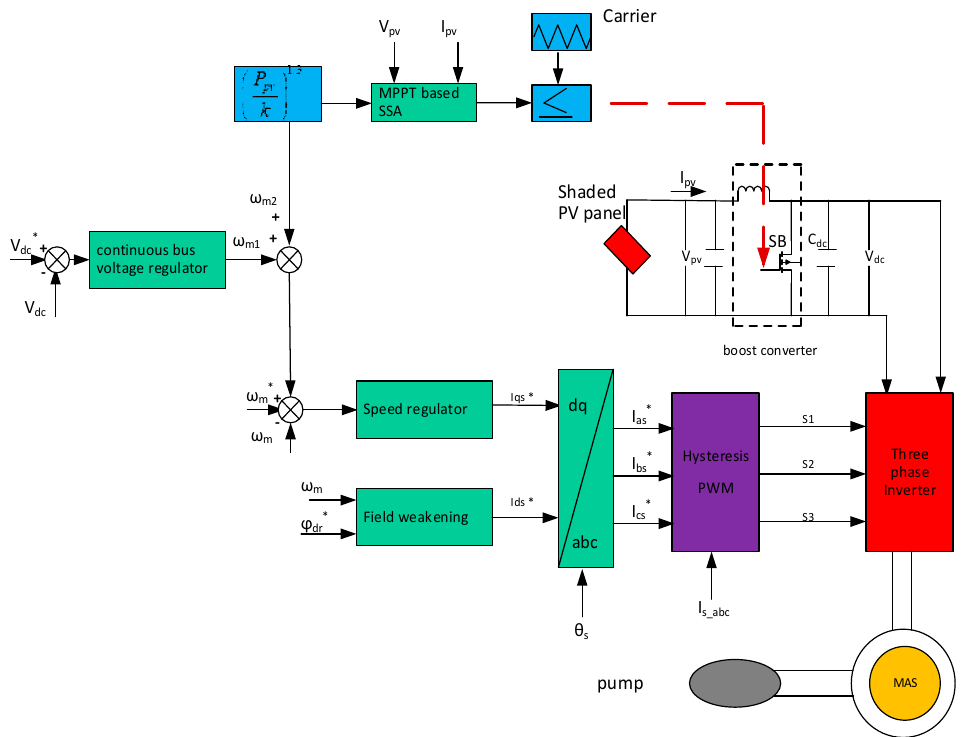
Figure 3. Overview of the photovoltaic pumping system equipped with maximum power point tracking (MPPT) and Indirect Field Oriented Control (IFOC) controls.